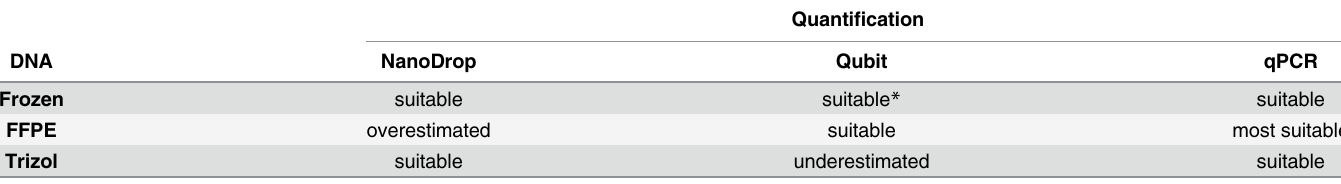
Table 1. Recommended quantification methods for DNA available for